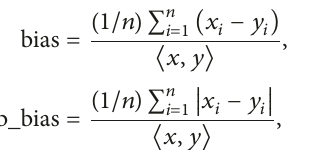
well with the results from the OTT, and some noises were observed in the results of PMCS and OTT, which could be caused by the instruments, and the distribution of rain rate calculated from the rain gauge is flatter than the results from PMCS and OTT. The general distribution of accumulated rainfall among the results of PMCS, rain gauge, and OTT is similar, while the accumulated rainfall growth by PMCS is much closer to the result of rain gauge; the accumulated rainfall recorded by PMCS, OTT, and rain gauge is 426.8 mm, 480.8 mm, and 412.7